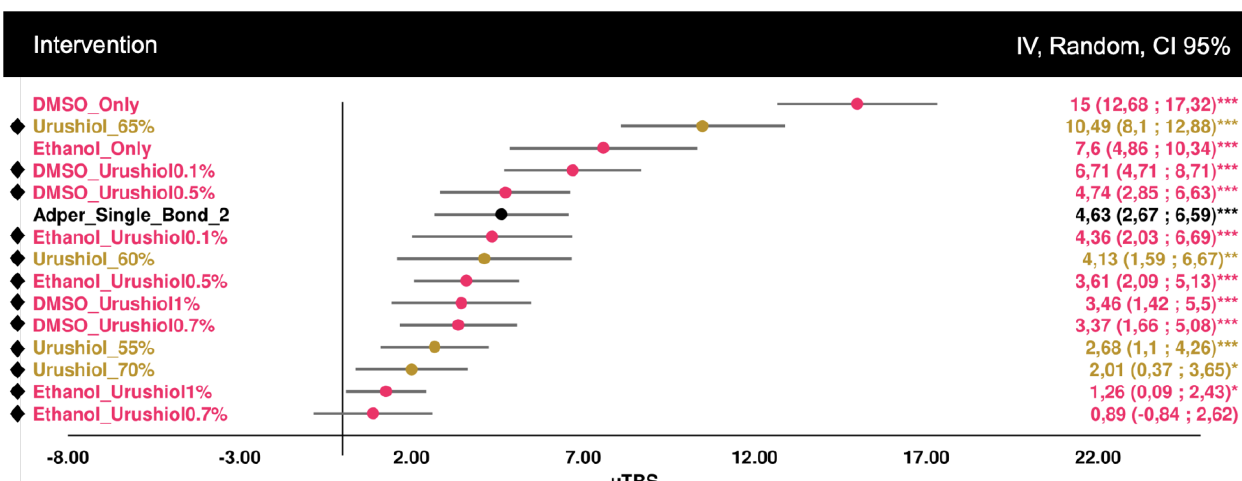
Figure 2. Forest plot of the immediate microtensile bond strength, including 7 distinct studies with different strategies and 3 commercial controls, which do not have any symbol, purposefully—Adper Single Bond 1, Adper Single Bond 2 and Solobond M. Symbol legend: ★ eugenyl methacrylate de- rivatives; ● methacrylamide derivatives; ◆ urushiol derivatives; ⬟ CBA monomer derivatives.